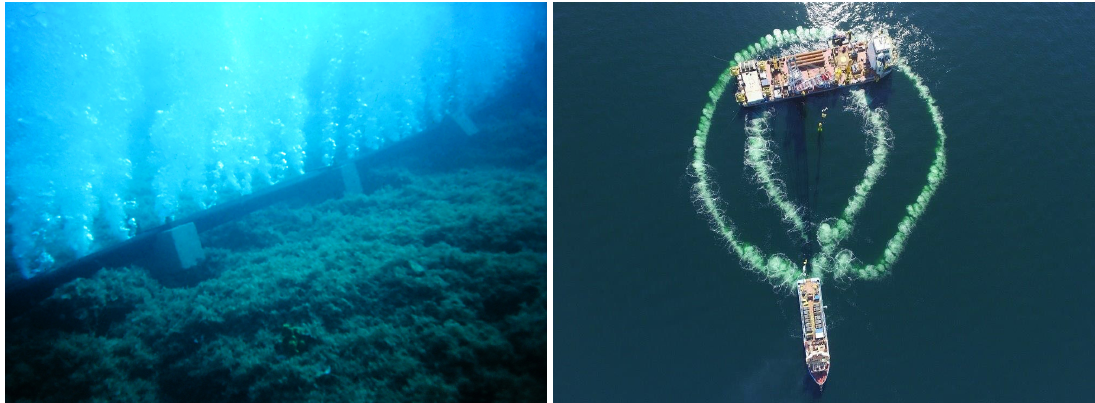
Figure 12. ( Left ) Air-bubble cloud released by a perforated pile positioned on the seabed. ( Right ) Double Big Bubble Curtain (DBBC) deployed around the Giant7 floating piling vessel in the Wikinger OWF, Germany. Source: c (cid:13) Hydrotechnik Lübeck GmbH (https://www.hydrotechnik-luebeck.de/